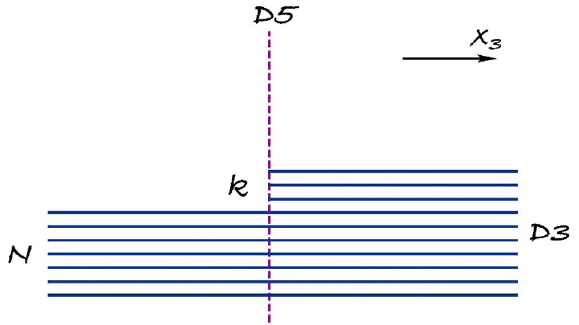
Figure 1 . The D3-D5